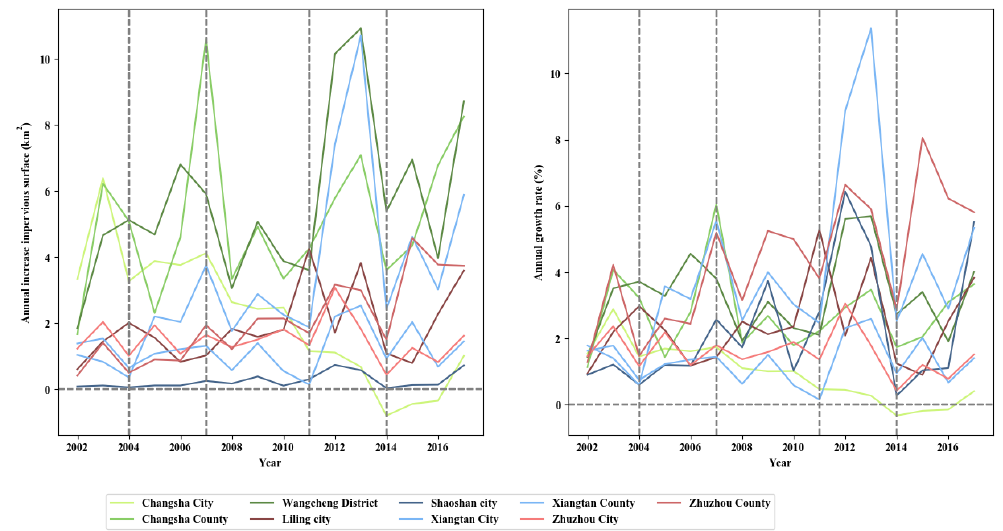
Figure 5. Annual increase (AI) of impervious surface (km2) ( left ) and annual growth rate (AGR) (%) ( right ) for CZTUA from 2001 to 2017. The vertical gray lines are milestones of significant policies.